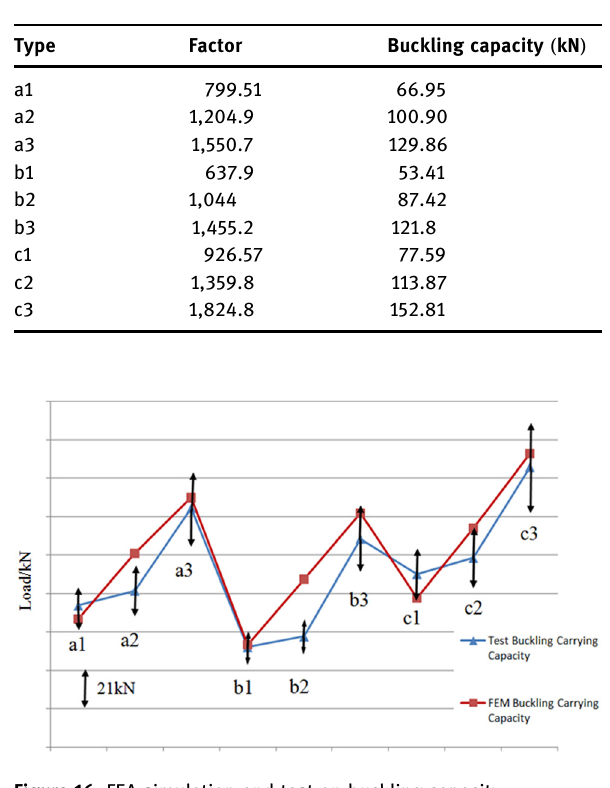
Figure 16: FEA simulation and test on buckling